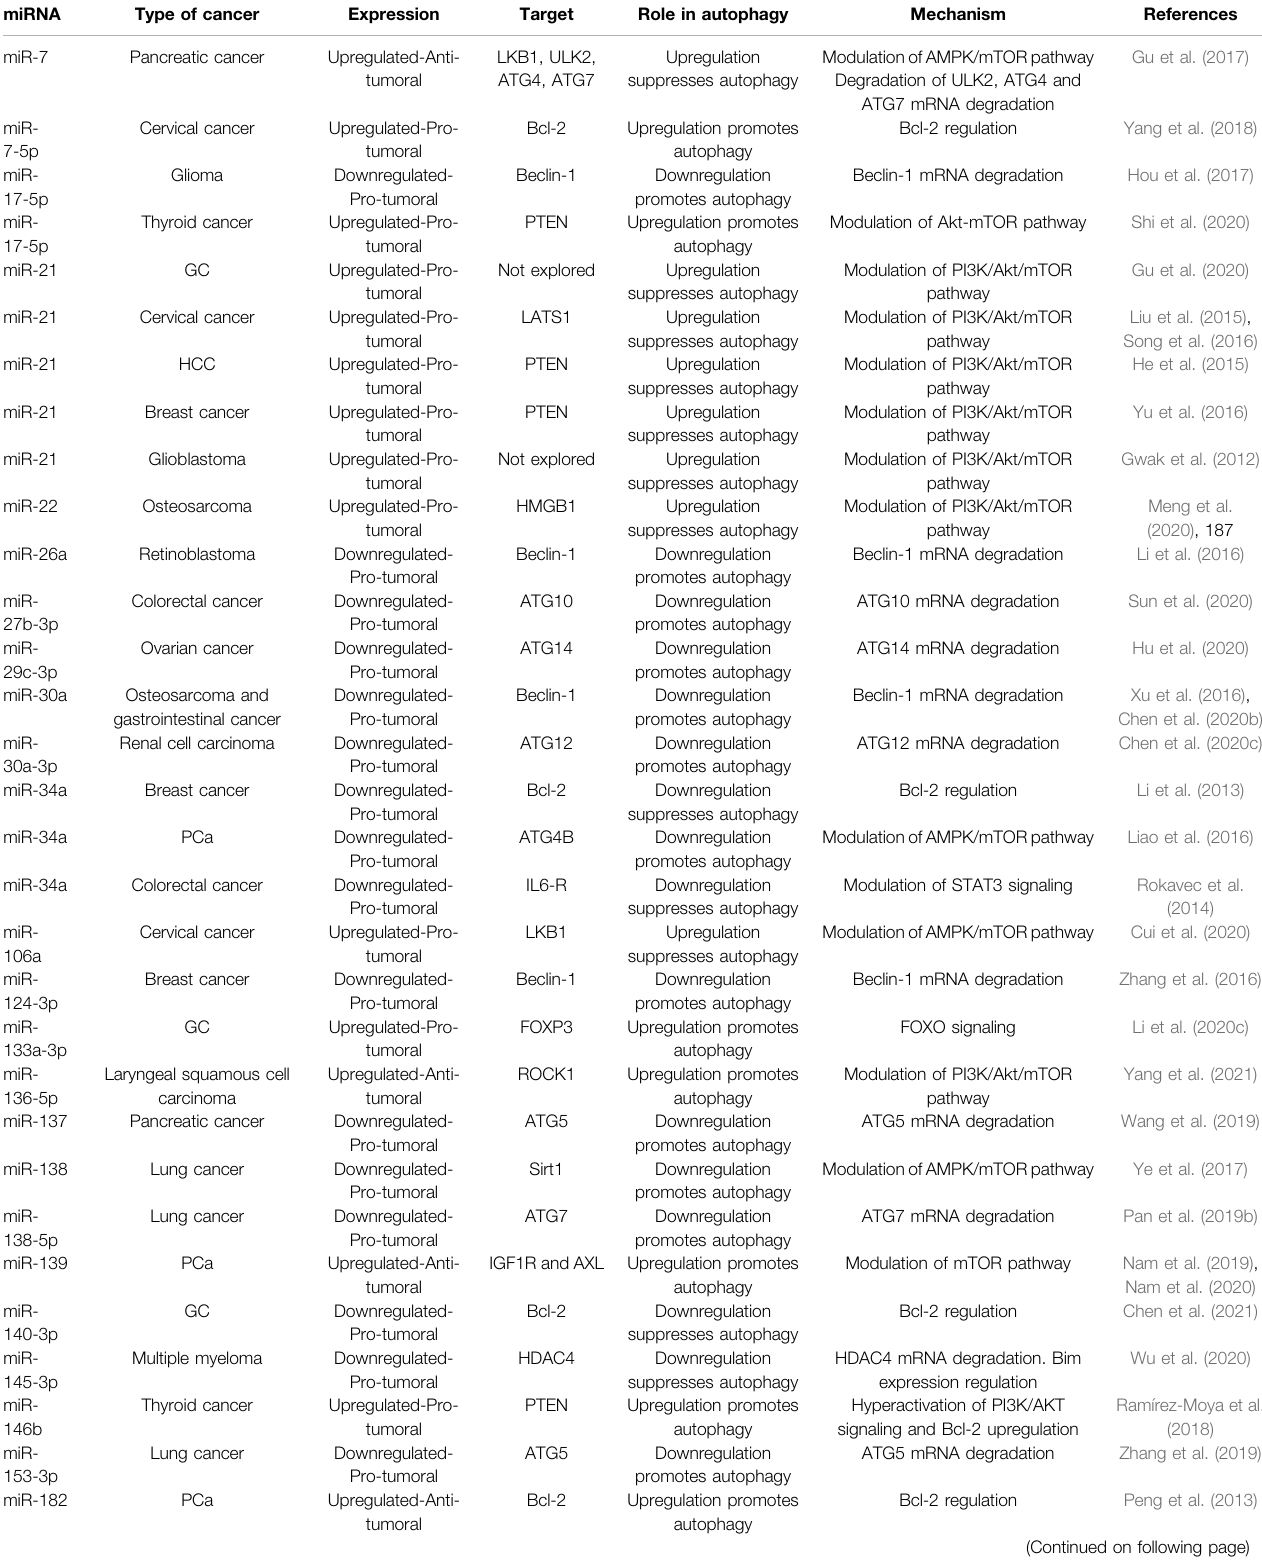
TABLE 2 | Role of miRNA in autophagy. Hepatocellular carcinoma, HCC; Gastric cancer, GC; Prostate cancer, PCa.